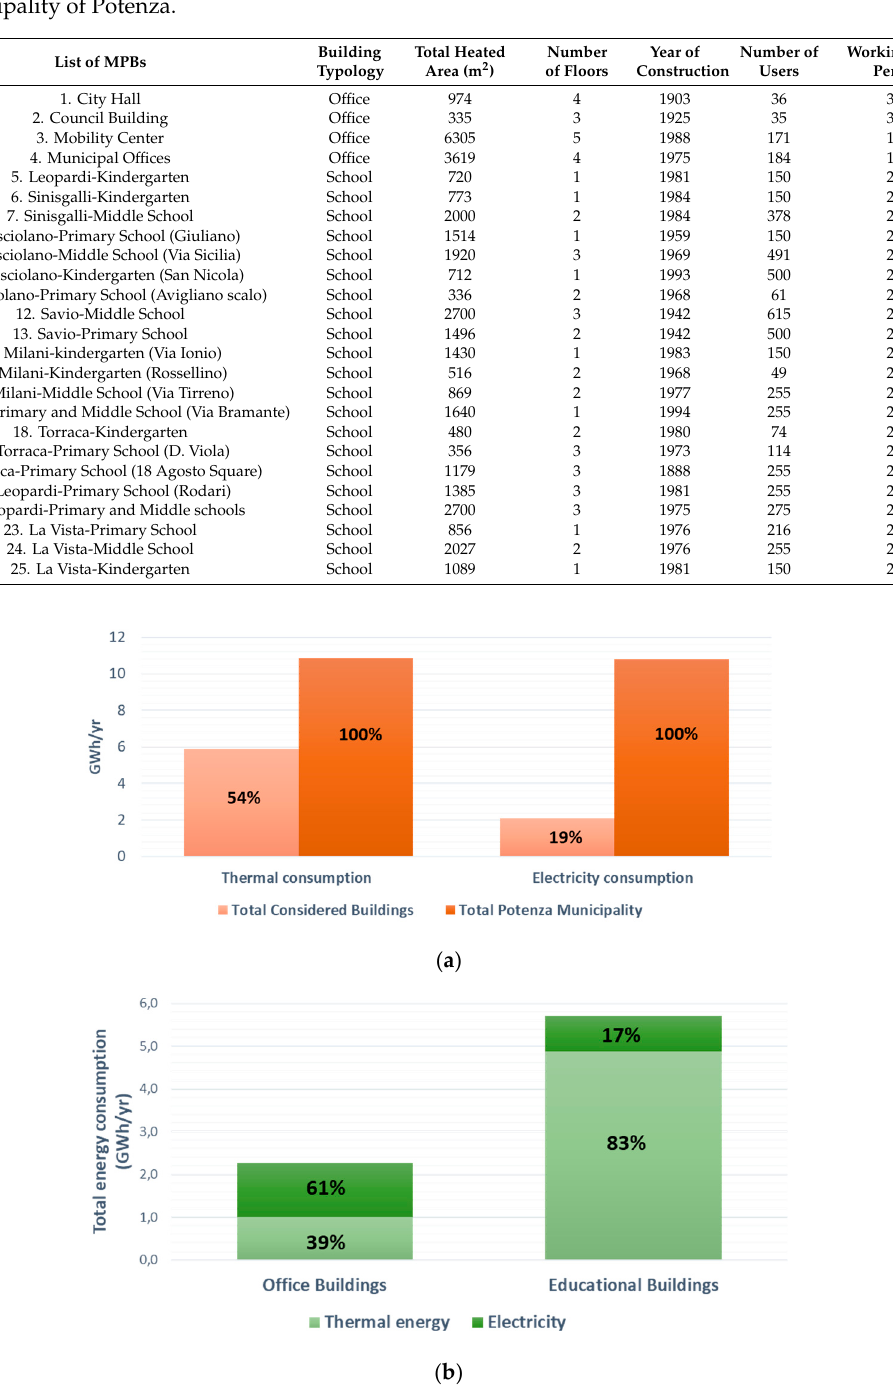
Figure 3. Thermal and Electricity Consumptions of the selected MPBs: ( a ) compared to total values for the Municipality of Potenza; ( b ) per